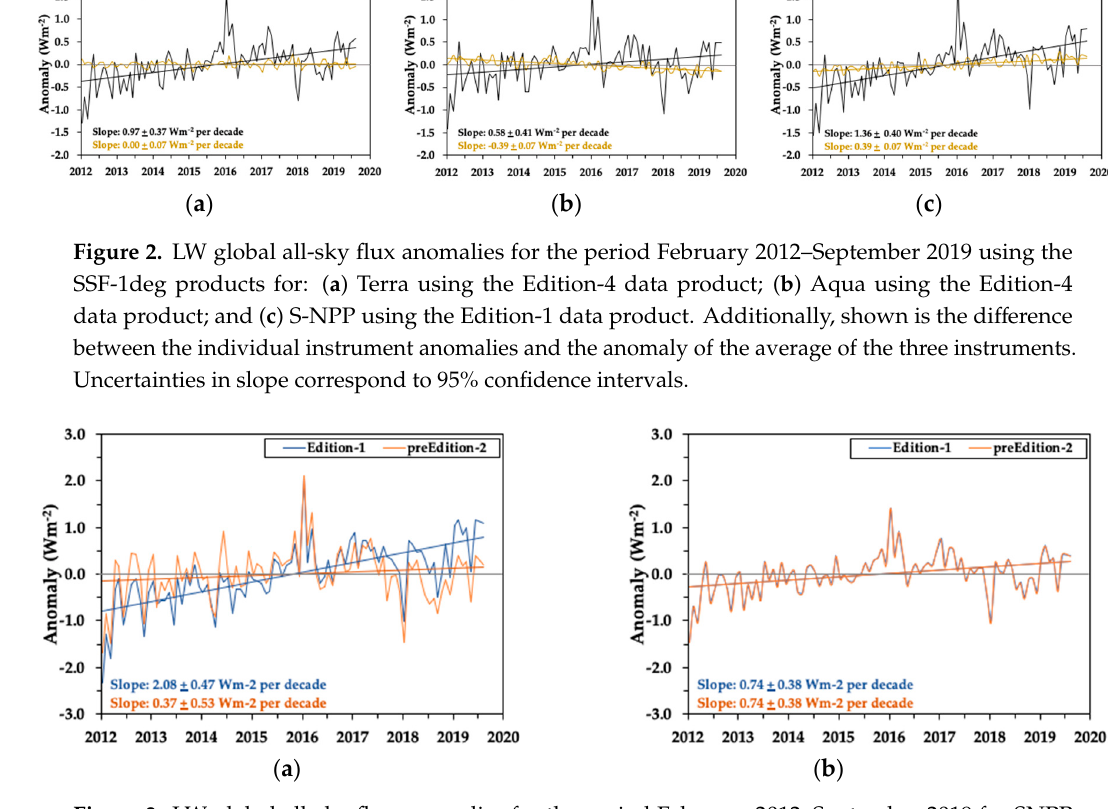
Figure 3. LW global all-sky flux anomalies for the period February 2012–September 2019 for SNPP using Edition-1 and preEdition-2 SSF products for: ( a ) daytime; ( b ) nighttime. Additionally, shown are the slopes of the trend with time and their corresponding 95% confidence intervals.